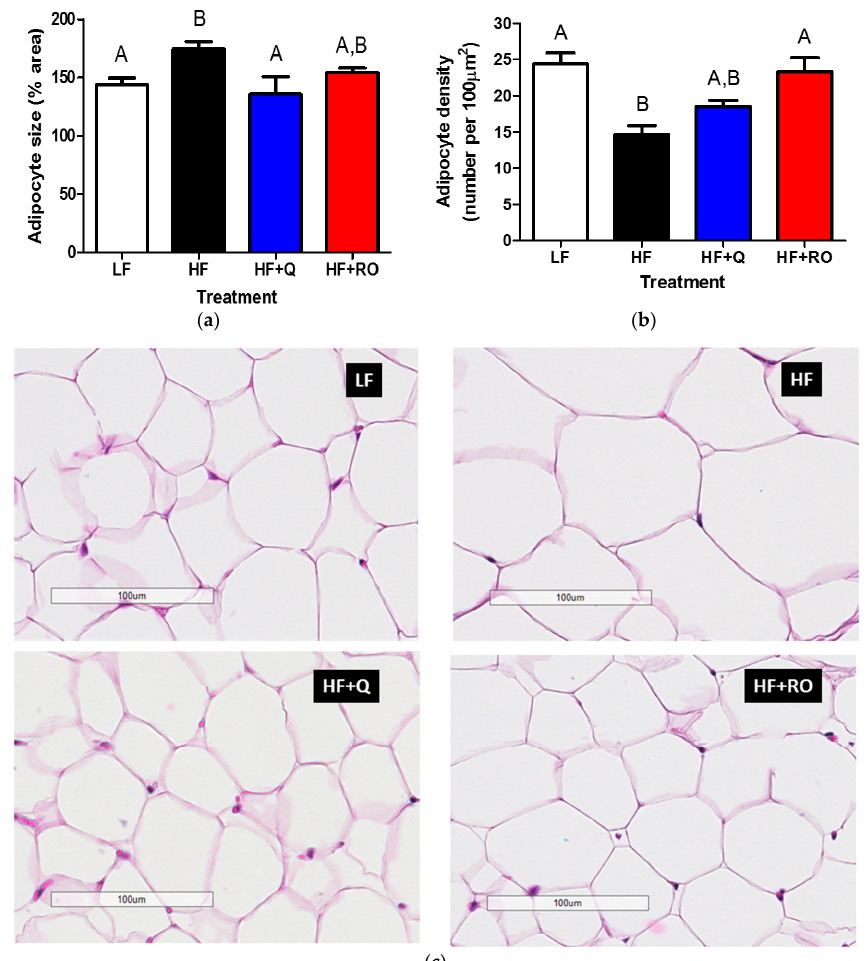
Figure 3. Adipocyte size ( a ) as the percent area, or the number of adipocytes in a given area of tissue, and density ( b ) were determined in epididymal white adipose tissue (EWAT) from mice were fed low fat (LF; white), high fat (HF; black), high fat + quercetin (HF + Q; blue) or high fat + ROE (HF + RO; red) diets and representative images are shown ( c ). Graphs are mean ± SEM. Different letters denote significant differences between groups at p <0.05.